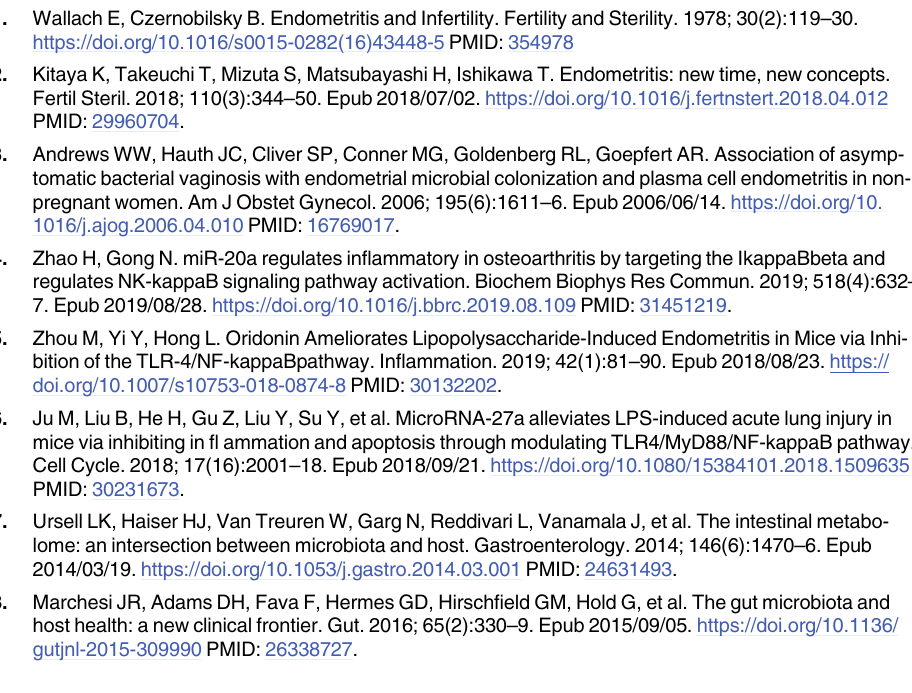
S1 Table. Raw data processing statistics. S2 Table. Relative abundance of microbiota at phylum and genus